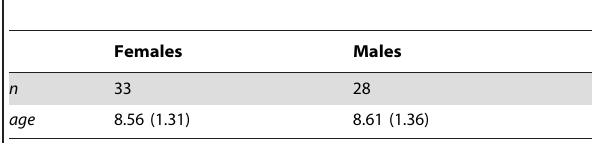
Table 1. Characteristics of the study sample (n= 61) as indexed by age (yrs., mean + / 2 standard deviation [SD]).